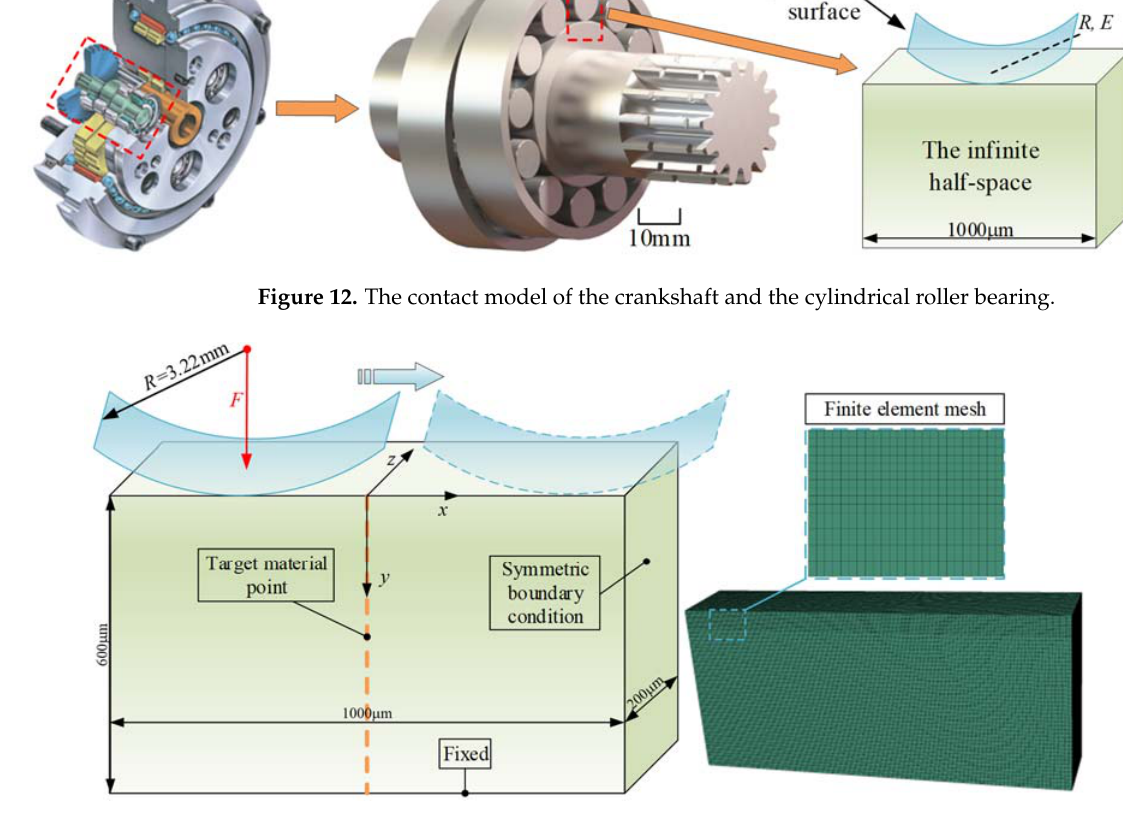
Figure 13. The numerical elasto ‐ plastic contact model.